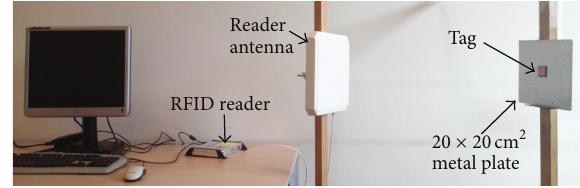
Figure 14: Read range measurement setup.